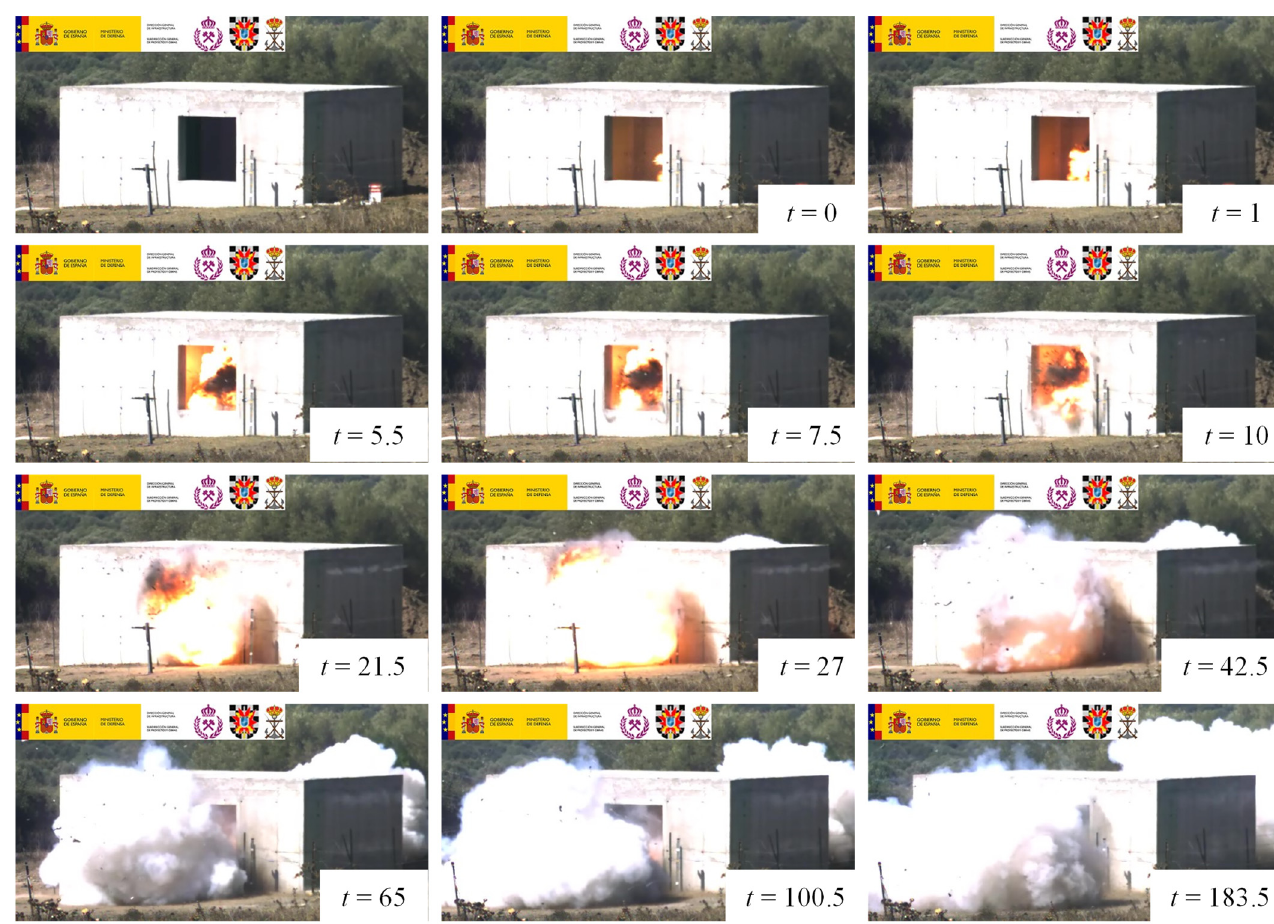
Figure 4. Sequence of images obtained with HSC in trial T2: black powder. Time in milliseconds; the reference time is the first frame of the video where the detonation is observed.